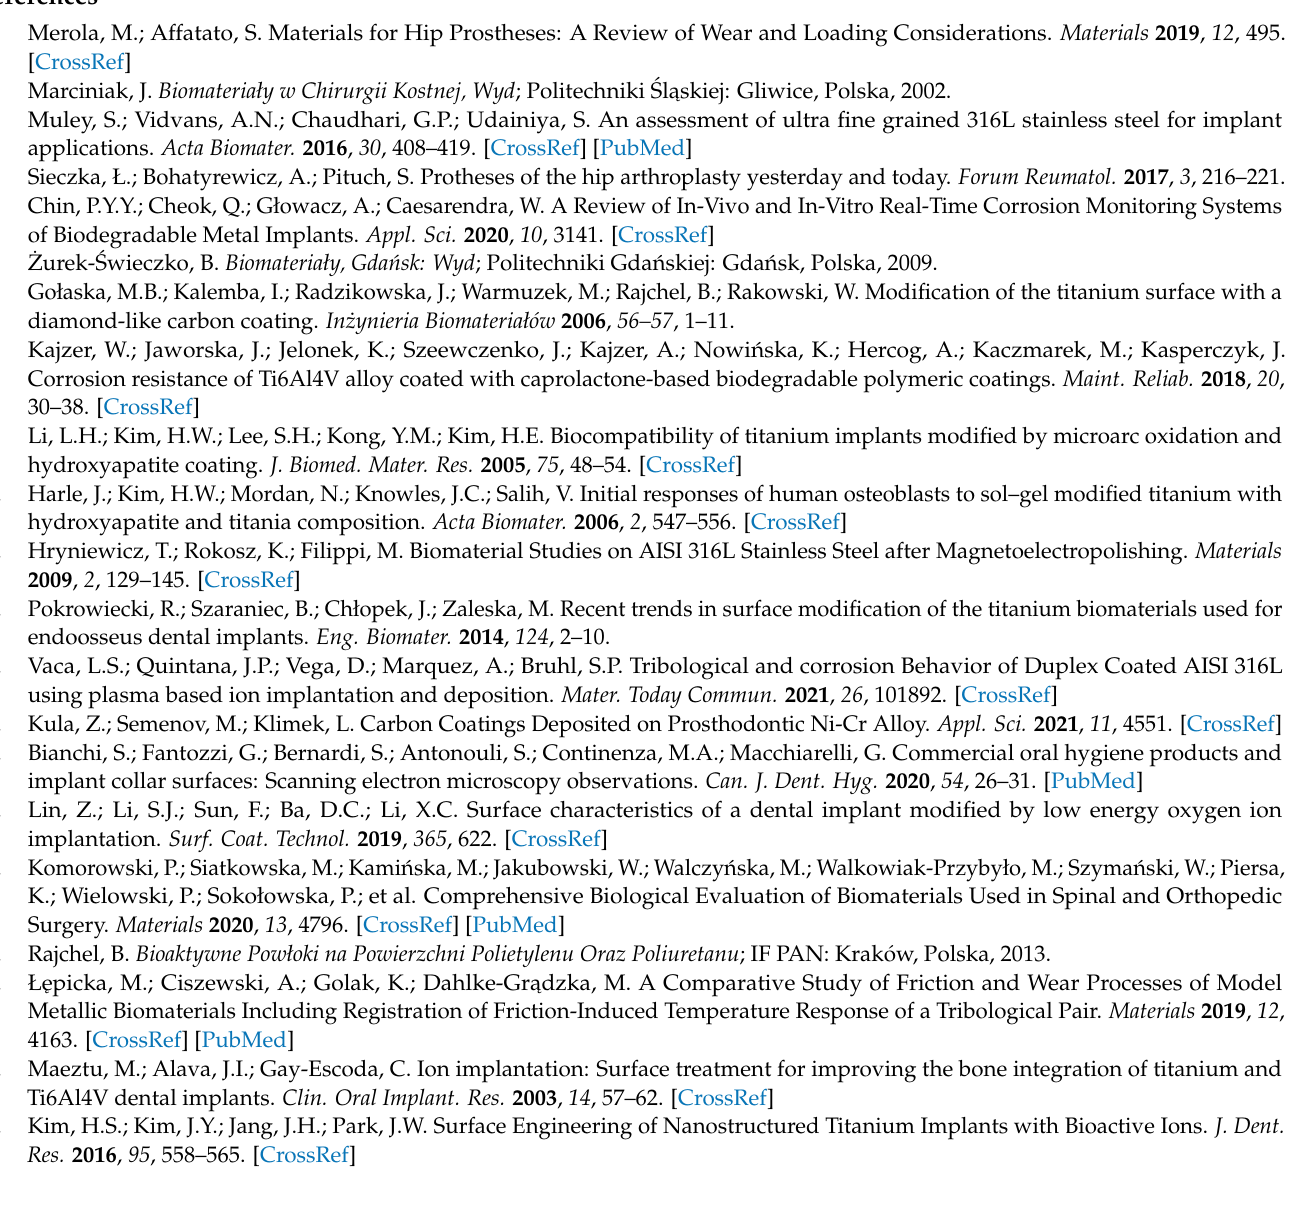
6. The microstructure analysis of wear tracks identified abrasive wear as the dominant wear mechanism in the case of the reference sample and that implanted with oxygen ions. The wear tracks were much wider and deeper compared to the 316L N + sample. The dislodging of loose wear products between friction surfaces resulted in cracks and